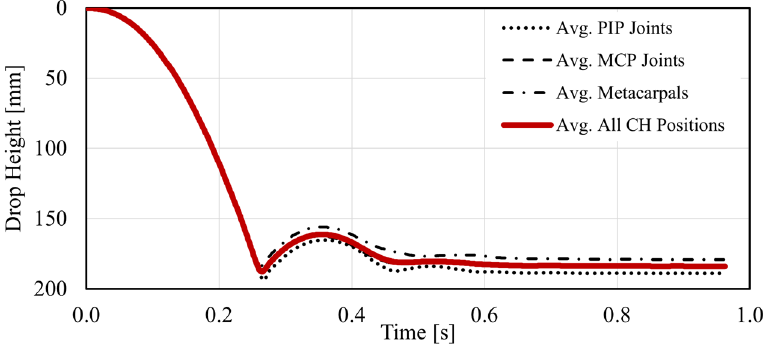
Figure 5. Impactor trajectory obtained from controlled impact tests with cadaveric hands (CH). PIP corresponds to proximal interphalangeal joints; MCP corresponds to metacarpophalangeal joints. Full details can be found in [7].